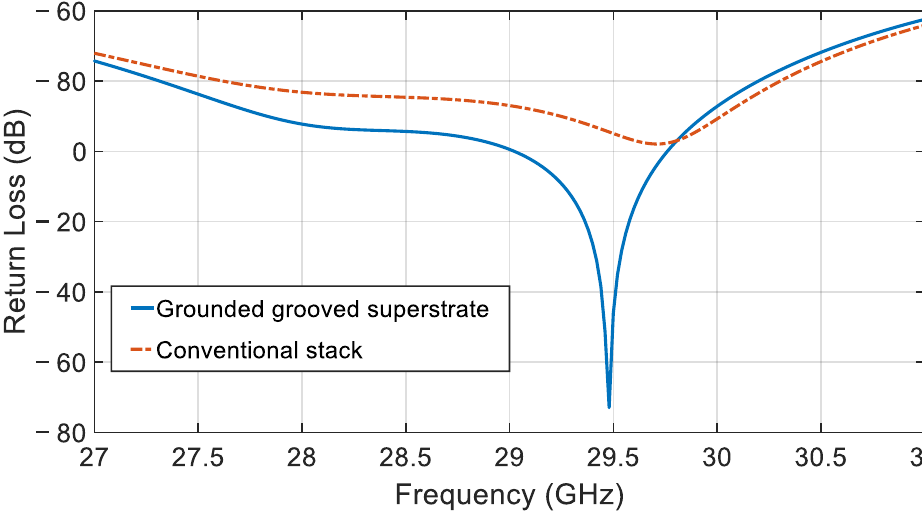
Figure 10. Return loss for the single element CDRA.